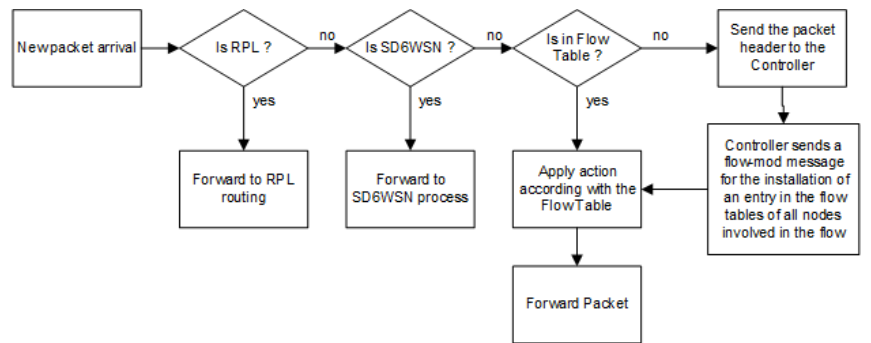
Figure 5. Flowchart for handling incoming packets in a